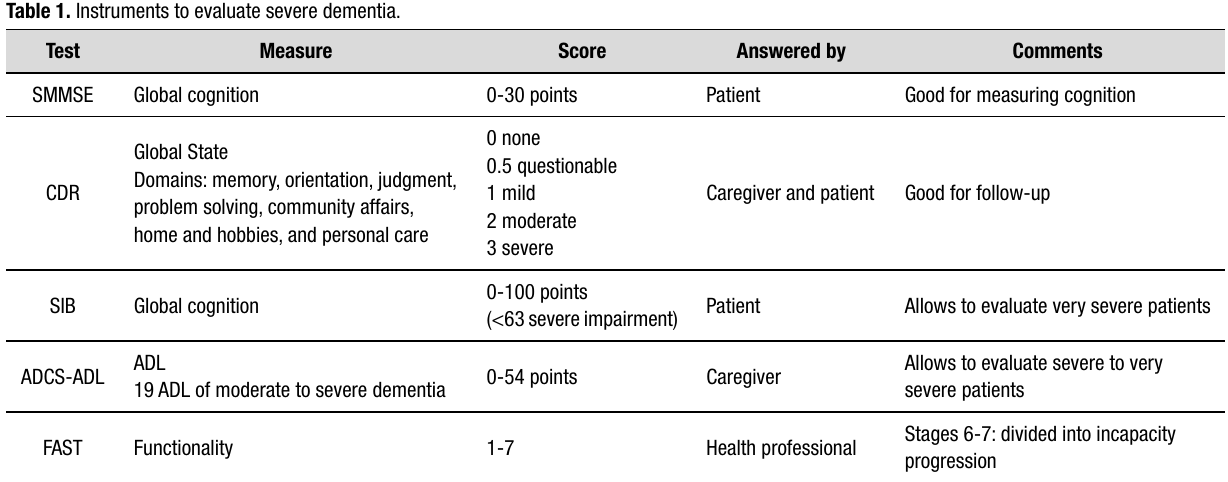
Table 1. Instruments to evaluate severe